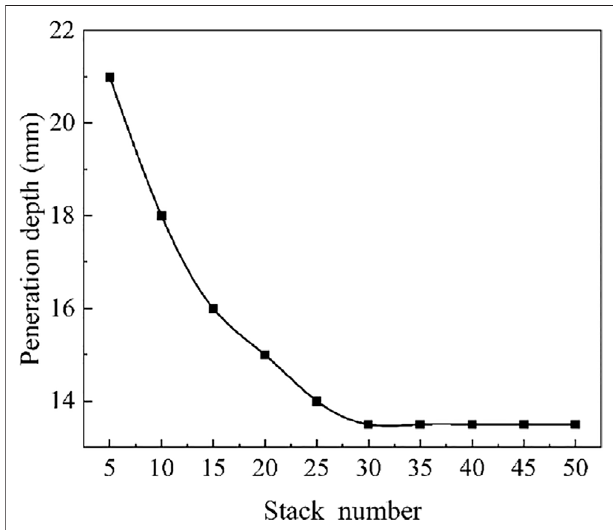
FIGURE 5 | Penetration depth of TC4-Al 3 Ti-Al